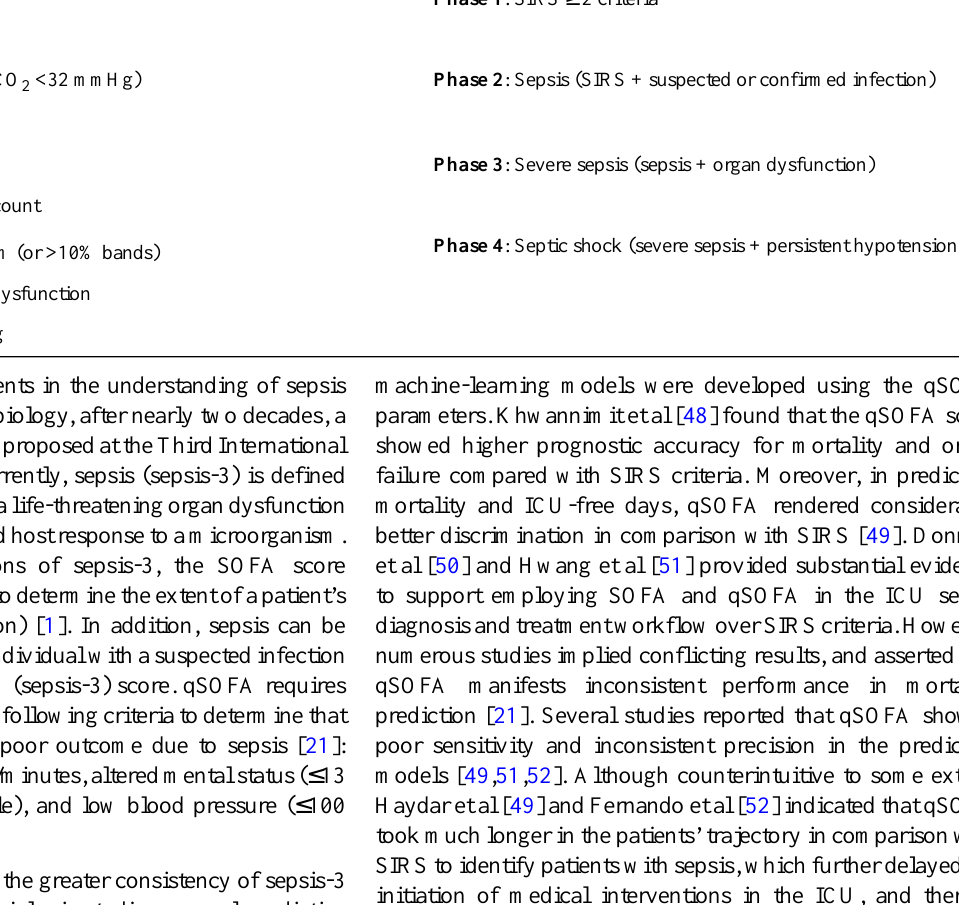
Phases of syndrome